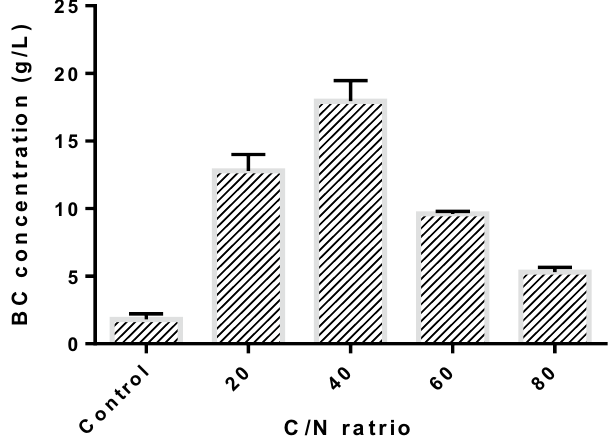
Figure 7. Effect of carbon to nitrogen ratio on BC production under shaking condition using biofilm fermentation (inoculum size: 5%, v/v, fermentation time: 15 d; initial pH: 5.5; nitrogen source: yeast